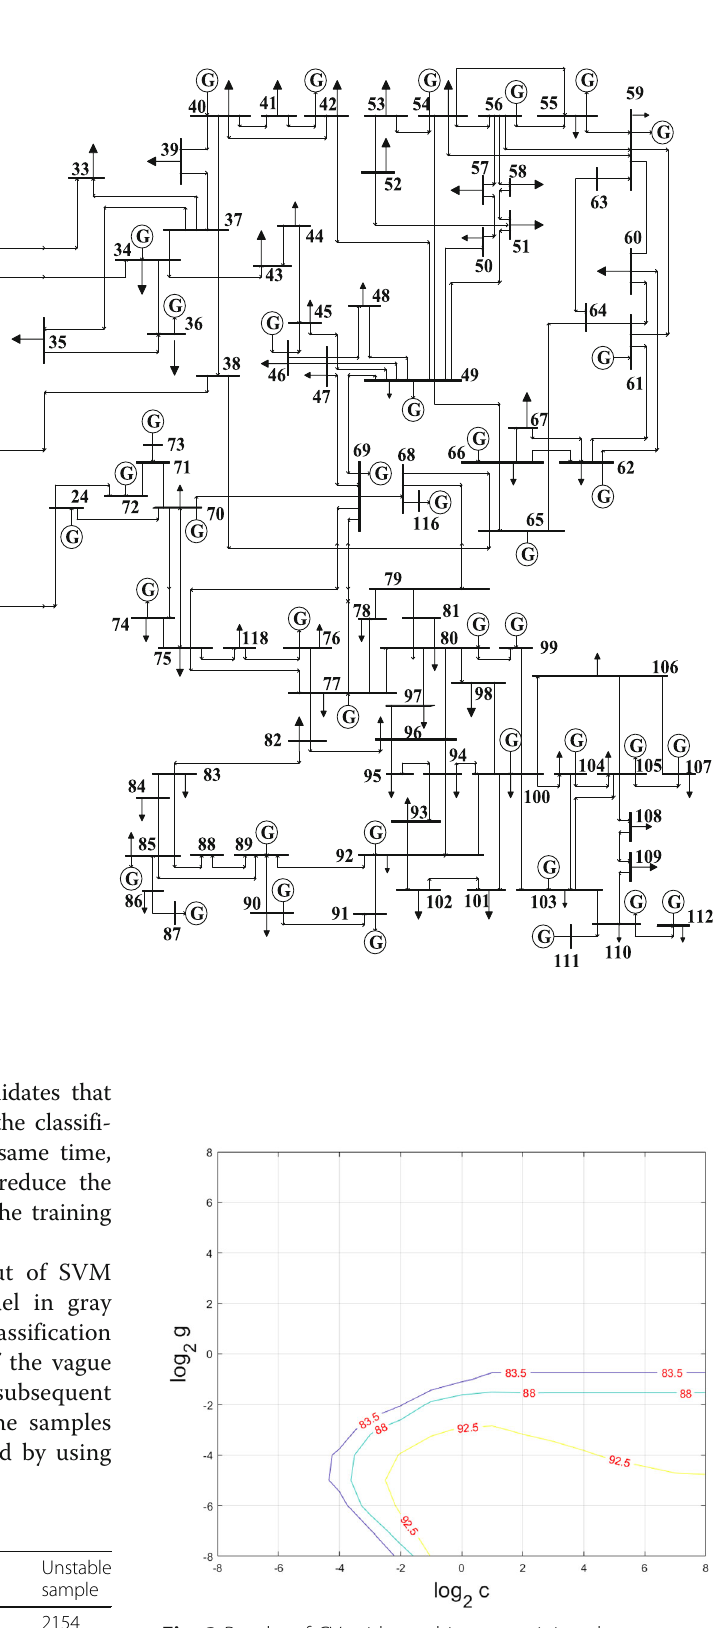
Fig. 3 Results of CV grid searching on training data